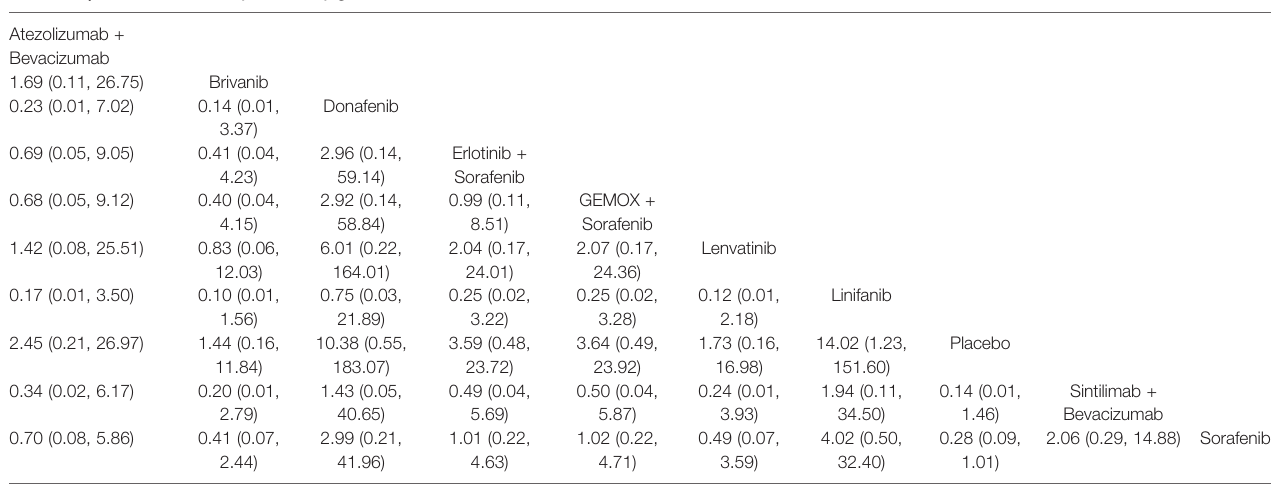
TABLE 4 | Network meta-analyses for any grade